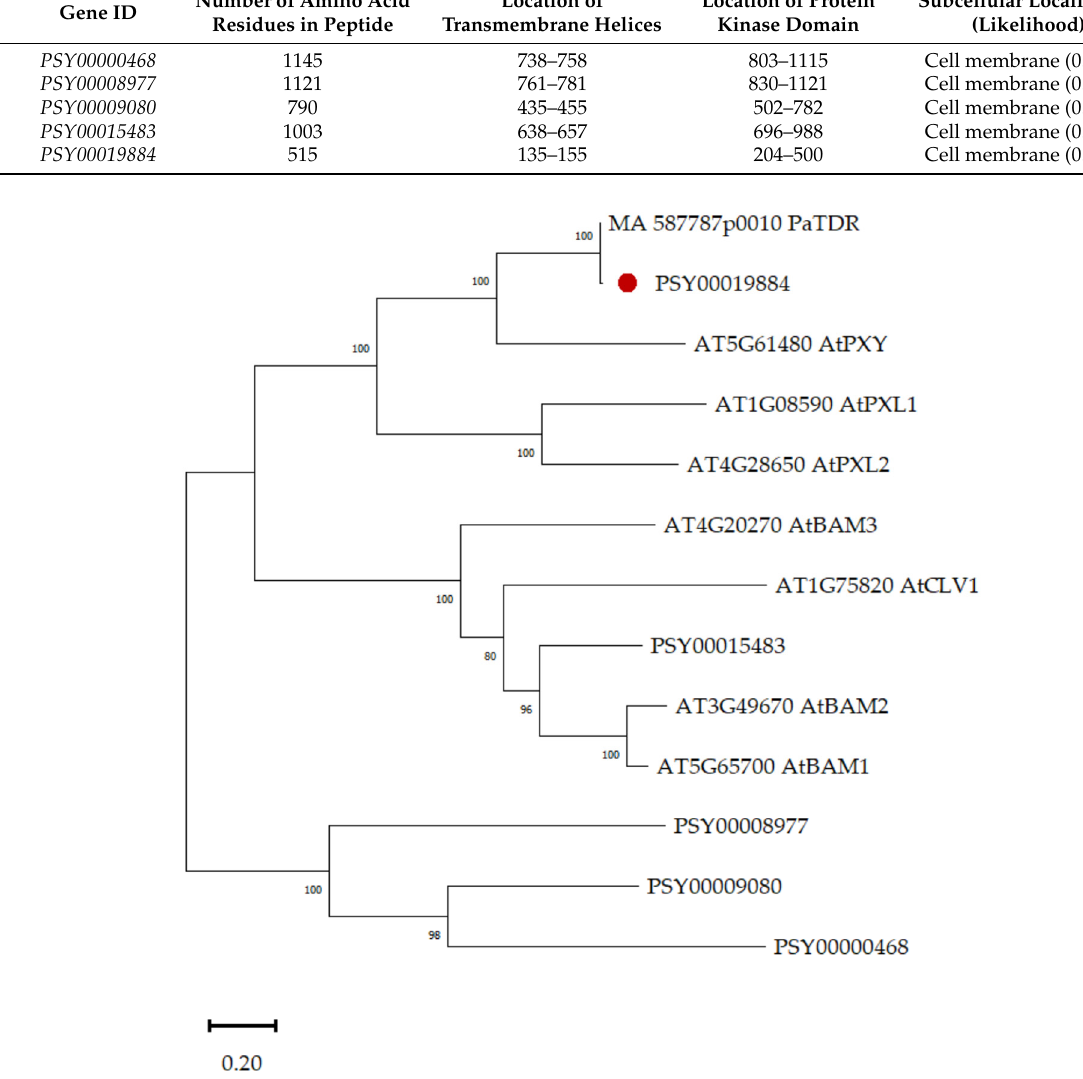
Figure 1. Phylogenetic relationships built based on a comparative evolutionary analysis of the amino acid sequences of potential Scotch pine (PSY) proteins and some known kinases of the LRR-RLK family of subgroup XI of Picea abies and Arabidopsis thaliana . Phylogenetic analysis by maximum likelihood (ML) method, based on LG with Freqs. (+F) model with a discrete gamma distribution (1 G, 5 categories) as the best model for gene phylogeny reconstruction. Branch length is estimated at genetic distance (number of substitutions per site). Significant bootstrap values (percentage of trees in which associated taxa are clustered together) for 1000 replicates are shown at the branch base. An access code in the Phytozome and Congenie databases is next to the protein names. The red dot is the protein encoded by the PsPXY , for which expression was analyzed.